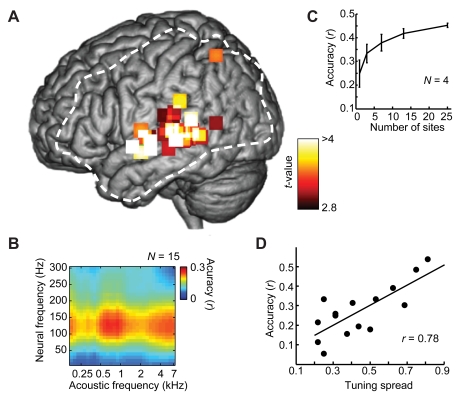
Factors influencing reconstruction quality.(A) Group average t value map of informative electrodes, which are predominantly localized to posterior STG. For each participant, informative electrodes are defined as those associated with significant weights (p<0.05, FDR correction) in the fitted reconstruction model. To plot electrodes in a common anatomical space, spatial coordinates of significant electrodes are normalized to the MNI (Montreal Neurological Institute) brain template (Yale BioImage Suite, www.bioimagesuite.org). The dashed white line denotes the extent of electrode coverage pooled over participants. (B) Reconstruction accuracy is significantly greater than zero when using neural responses within the high gamma band (∼70–170 Hz; p<0.05, one sample t tests, df = 14, Bonferroni correction). Accuracy was computed separately in 10 Hz bands from 1–300 Hz and averaged across all participants (N = 15). (C) Mean reconstruction accuracy improves with increasing number of electrodes used in the reconstruction algorithm. Error bars indicate SEM over 20 cross-validated data sets of four participants with 4 mm high density grids. (D) Accuracy across participants is strongly correlated (r = 0.78, p<0.001, df = 13) with tuning spread (which varied by participant depending on grid placement and electrode density). Tuning spread was quantified as the fraction of frequency bins that included one or more peaks, ranging from 0 (no peaks) to 1 (at least one peak in all frequency bins, ranging from 180–7,000 Hz).